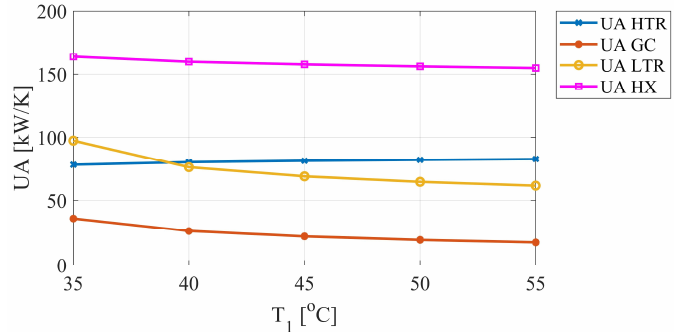
Figure 11. Heat transfer area coefficient ( UA ) vs. compressor inlet temperature ( T 1 ).